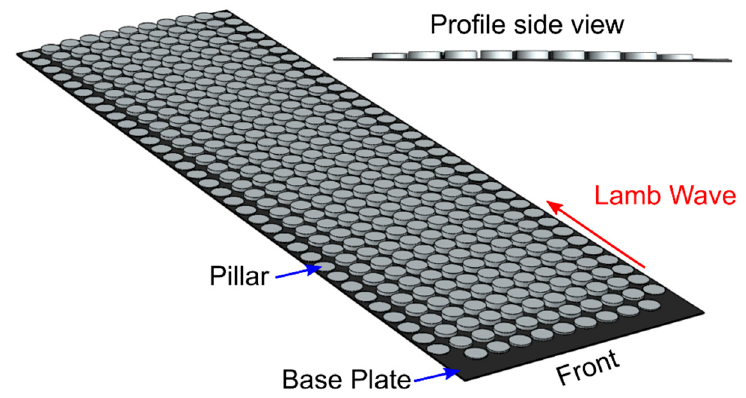
Figure 2. GRIN structure with tapered pillar height on the front edge. Pillar height profile for one row is shown.